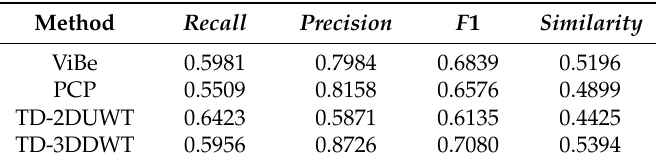
Table 9. Comparison of average metrics for the shopping center sequence.